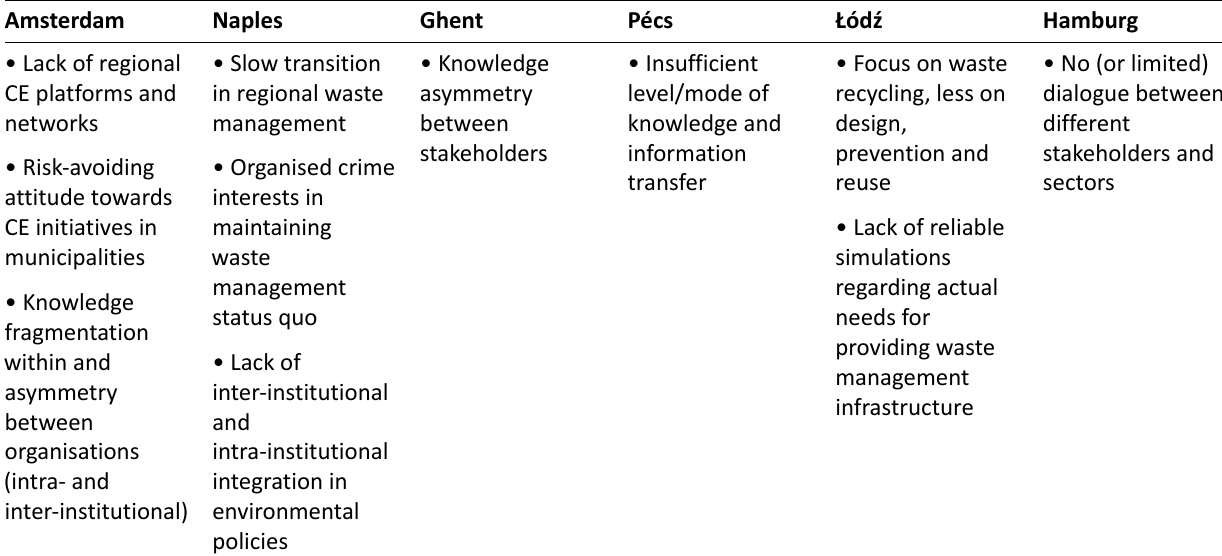
Table 8. Governance challenges: